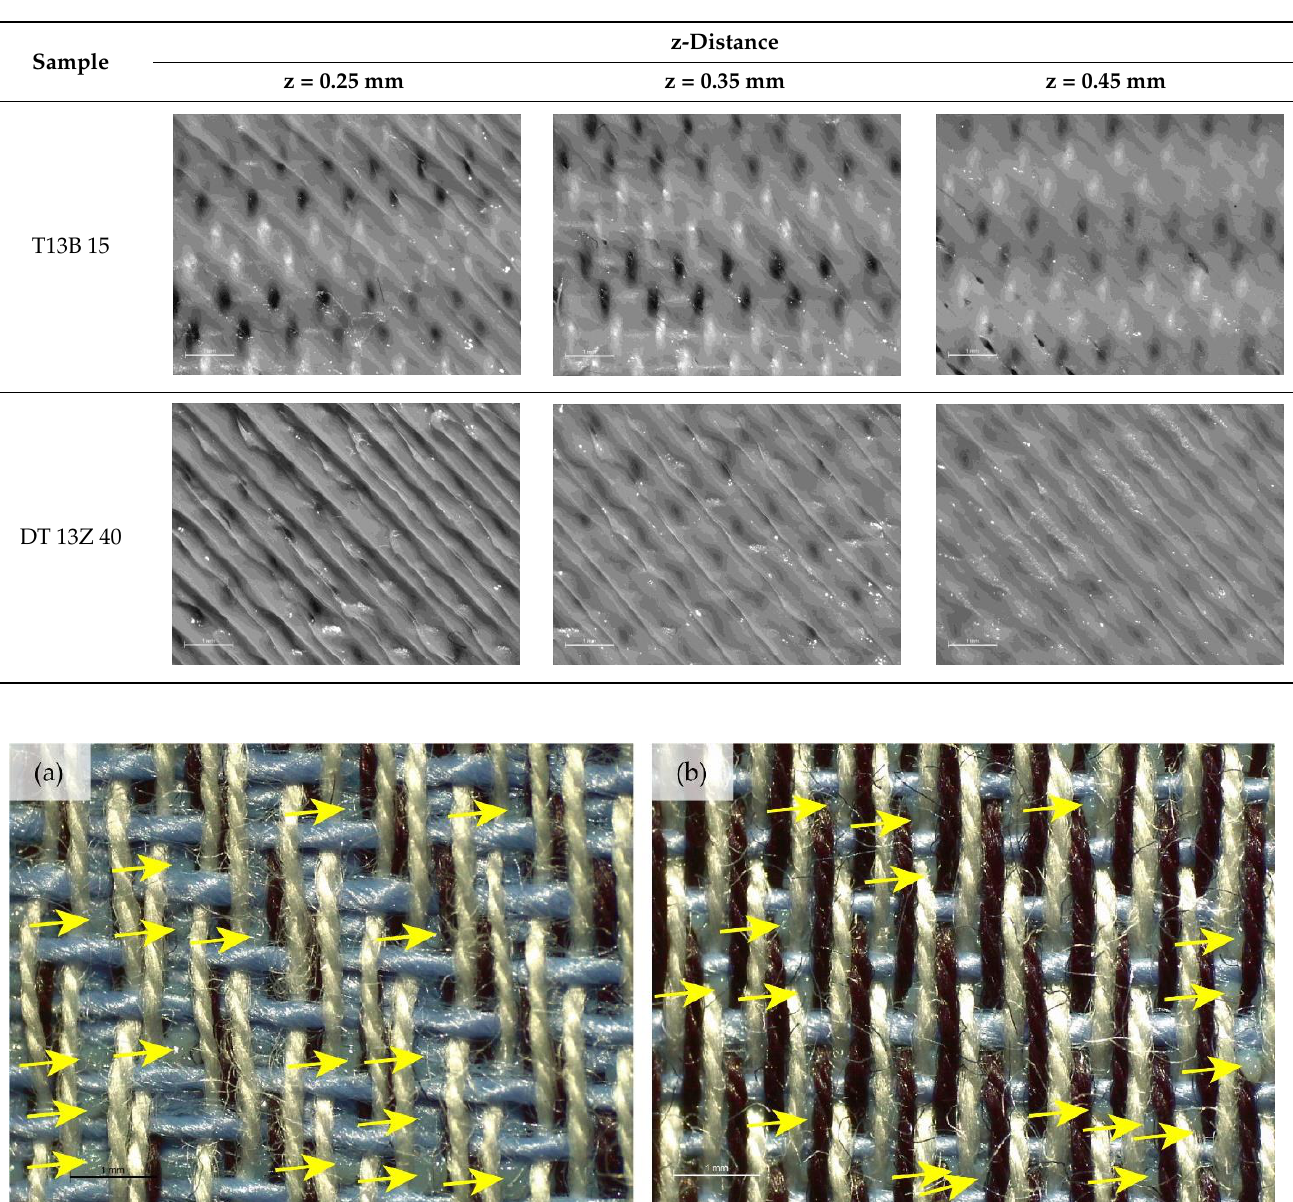
17 Figure 6. Interaction between density and weave in the analysis of the adhesion force for double